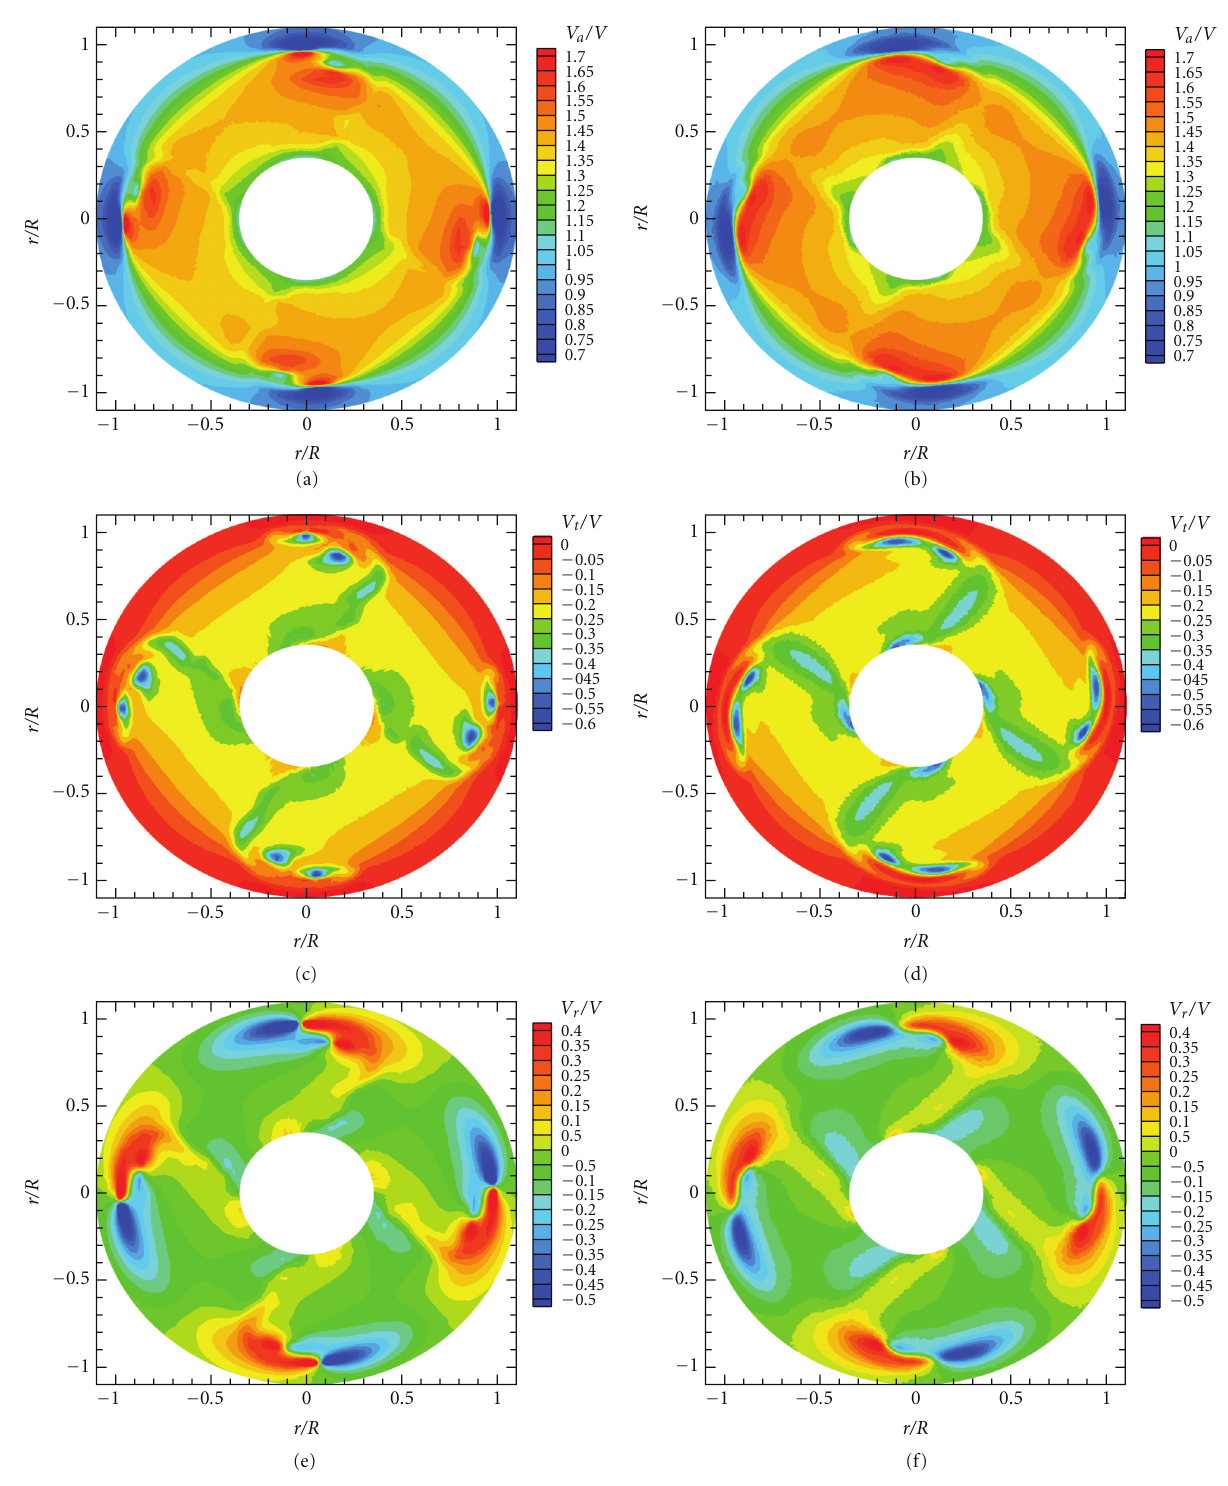
Figure 19: Axial, tangential, and radial nondimensional velocity distributions at x/R = 0.9875 aft the propeller plane. ((a), (c), and (e)) Experimental LDV measurements. ((b), (d), and (f)) RANSE computations on the finer